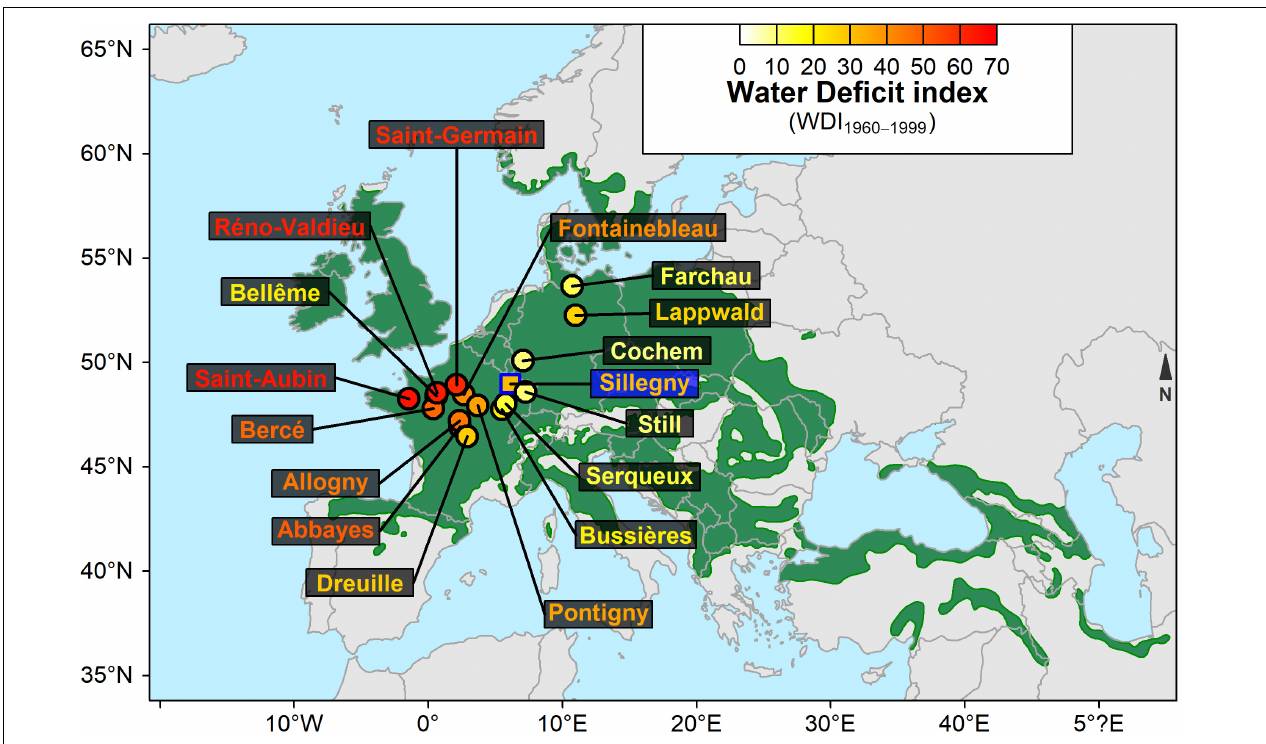
FIGURE 1 | Distribution map of the 16 provenance sites of sessile oak ( Quercus petraea ). The green area represents the current distribution area of sessile oak in Europe (Caudullo et al., 2017). A square indicates the common garden location (Sillegny). The color associated with each site refers to the mean value of water deficit index calculated for the period 1960 – 1999 (WDI 1960 - 1999 ). The Abbayes population is also called Soudrain in some